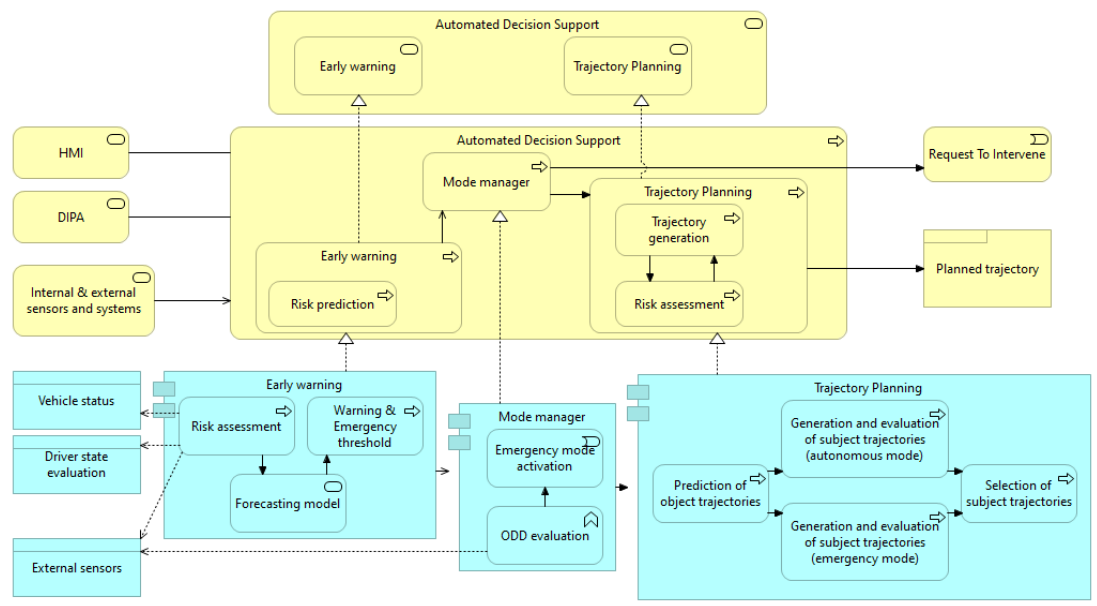
Figure 3. Archimate global architecture of the Automated Decision-Support